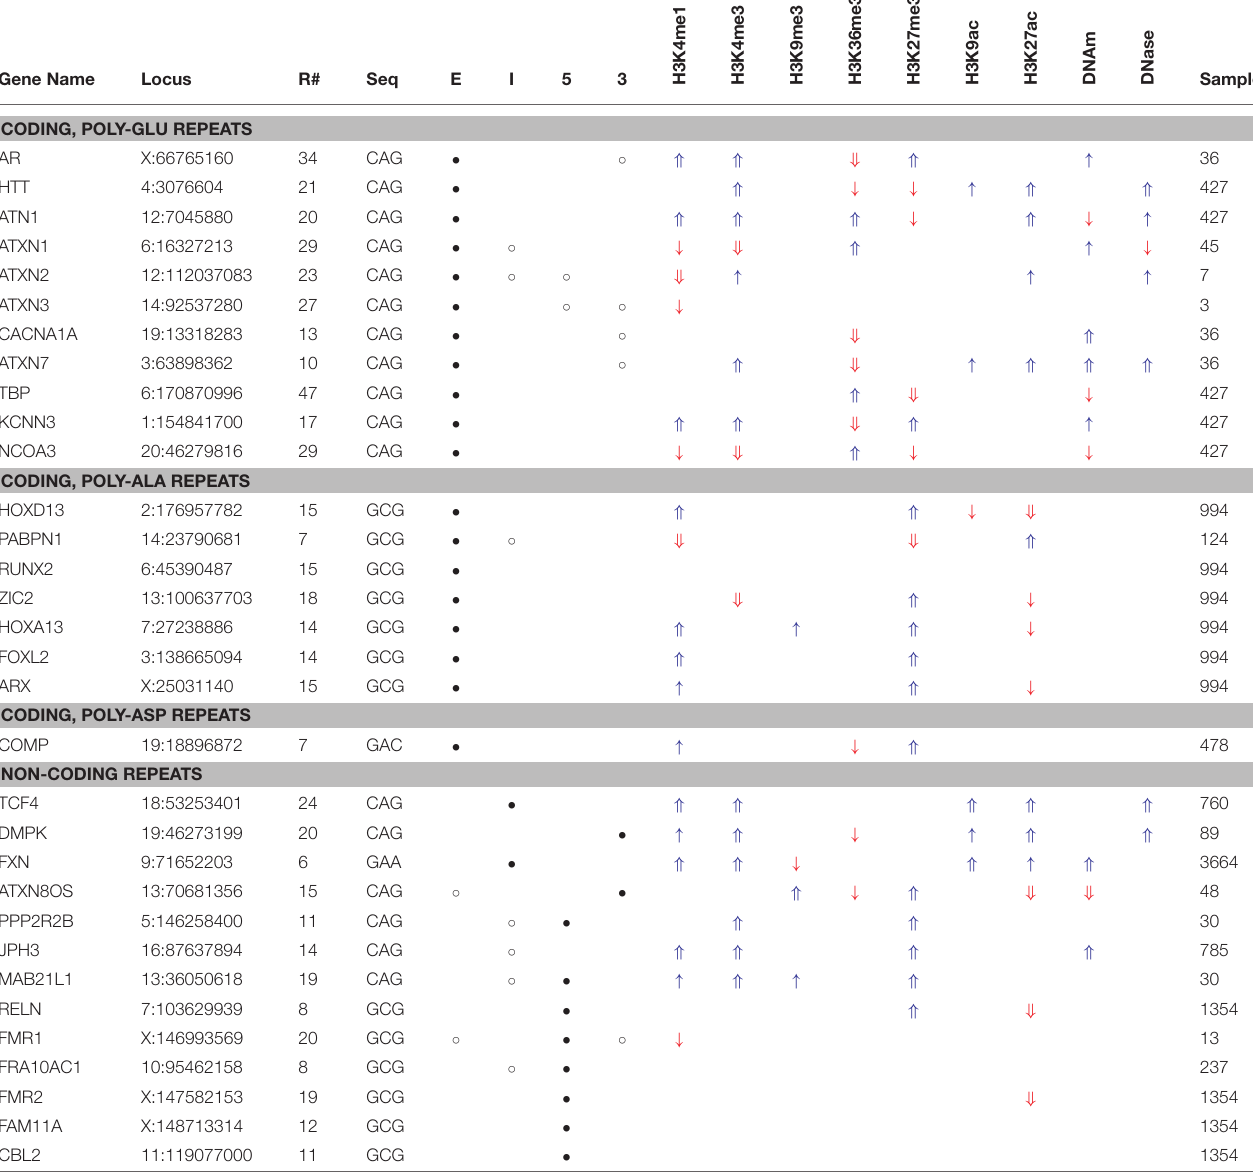
TABLE 4 | Over- and under-enriched epigenetic marks identified by M2 for individual DA-TNRs (see Figure 1).